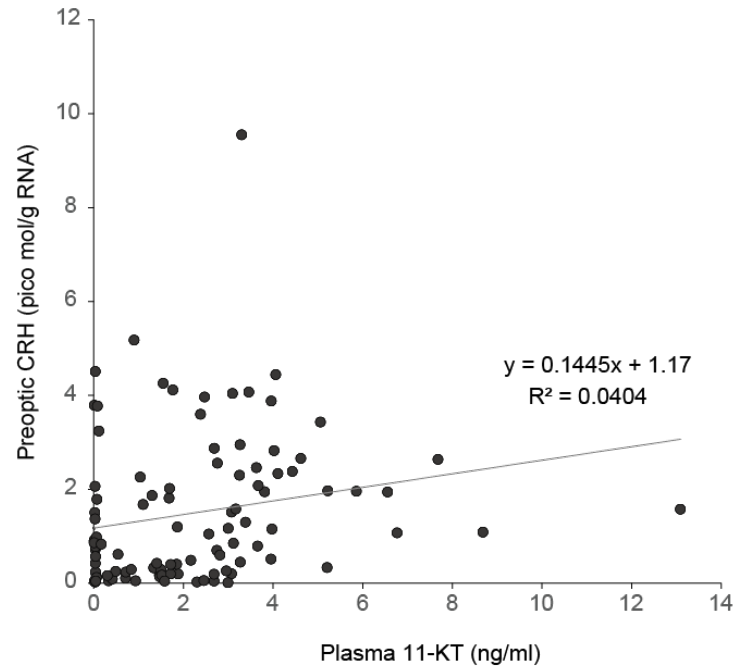
Figure 5. Correlation between plasma 11-KT and preoptic crh mRNA levels in wild female Japanese eels ( A. japonica ) (n = 100). Blood plasma was extracted with diethyl ether as following de Jesus et al. [112]. Analyses were made in duplicate on each sample using the 11-Keto-Testosterone ELISA Kit (Item No. 582751, Cayman Chemical Inc, ANN Arbor, MI, USA ) according to the manufacturer’s instructions. Brains of each fish were dissected out under microscopy, mixed with ISOGEN (Nippon Gene), and total RNA was isolated according to the manufacturer instructions. Total RNA was treated with RNase-free DNase I (Takara). After inactivation of DNase, reverse transcription was carried out using the SuperScript II First-Strand Synthesis System (Invitrogen). QPCR for crh was performed with LightCycler 480 Instrument (Roche Diagnostics) as described by in Yada et al. [113]. The sequences of primers in the assays to amplify crh were 5 (cid:48) -TCACGCAGCGTCTTTTGC-3 (cid:48) , for- ward; 5 (cid:48) -GCTGGCTAGCGTAGCTGCTT-3 (cid:48) , reverse, which were designed based on the Gene Bank accession number